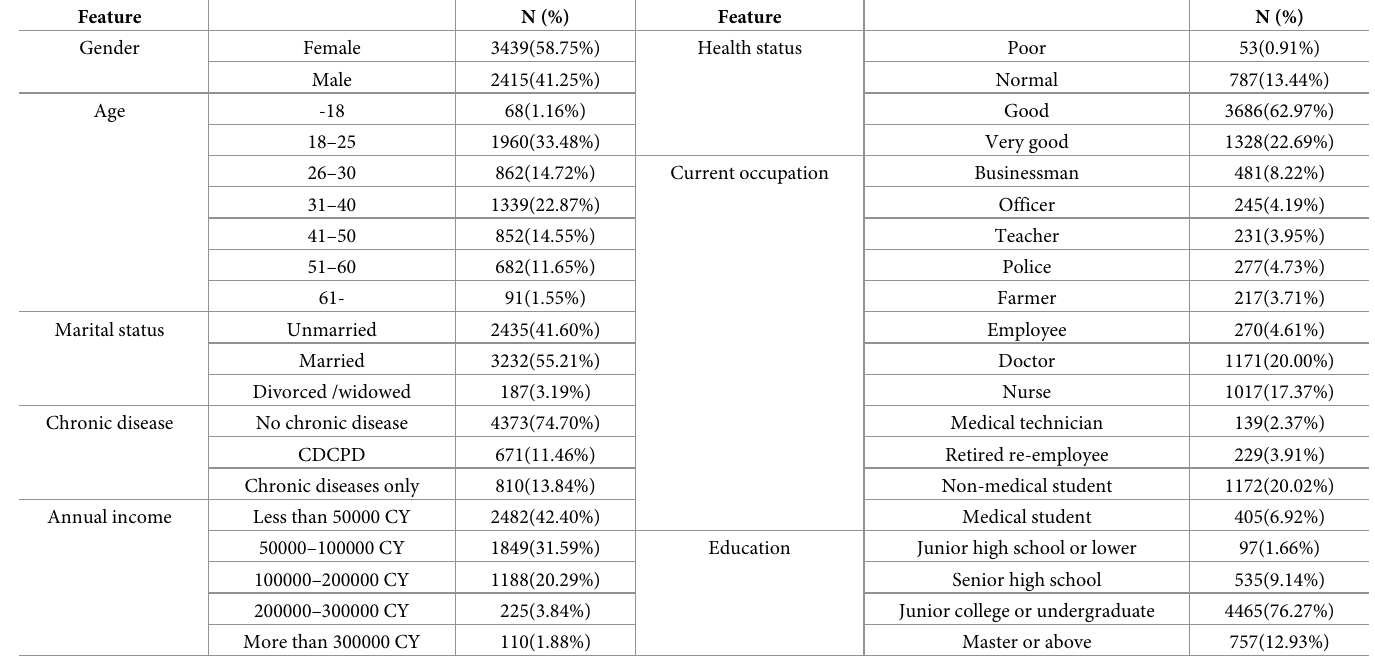
Table 1. General sociodemographic characteristics of 5854 analyzed